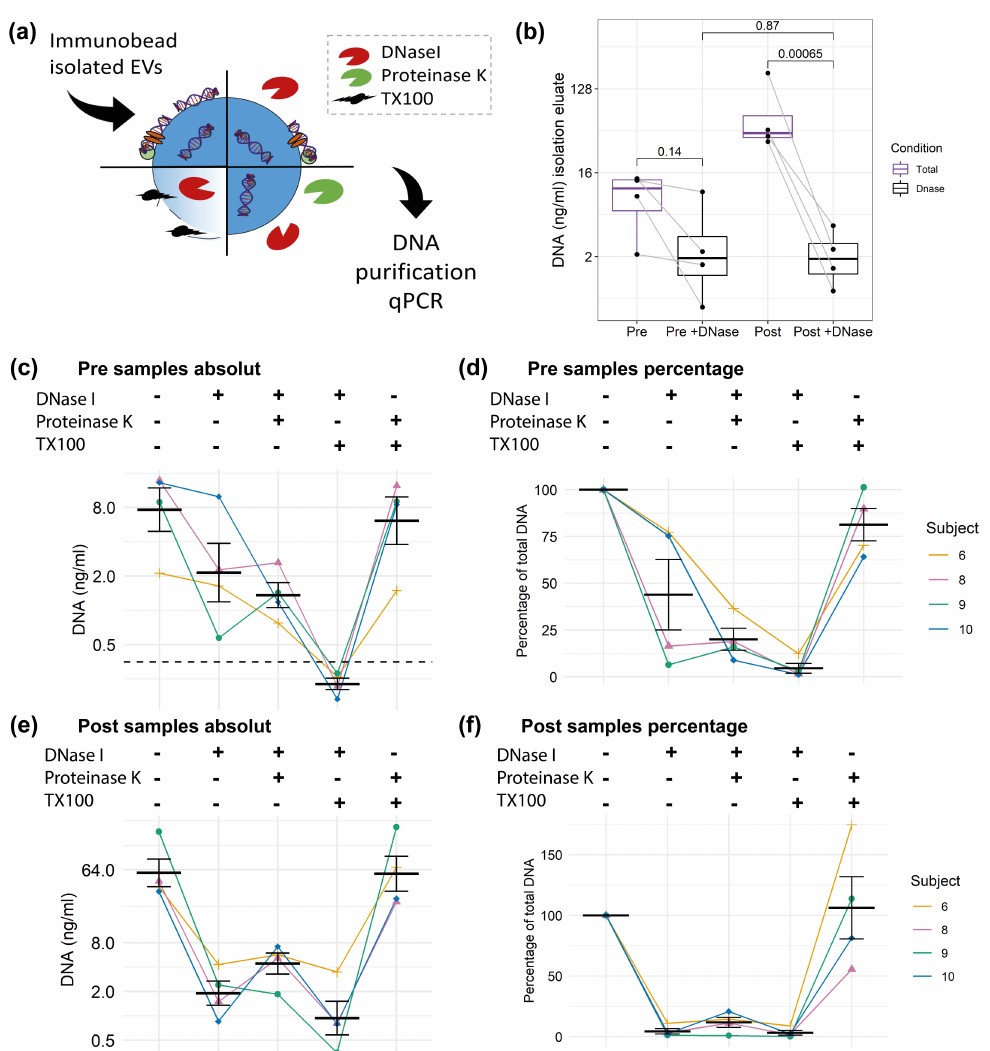
Figure 5. DNA cargo of CD9 + /CD63 + /CD81 + EVs. ( a ) Illustration of different digestion strategies. ( b ) Comparison of Pre and Post samples with or without DNase I digestion. Unadjusted t test results are displayed. Absolute and relative concentration of the Pre samples ( c , d ) and Post samples ( e , f ). Error bars indicate mean ± SEM. The dashed black line indicates the limit of detection (LOD) of the